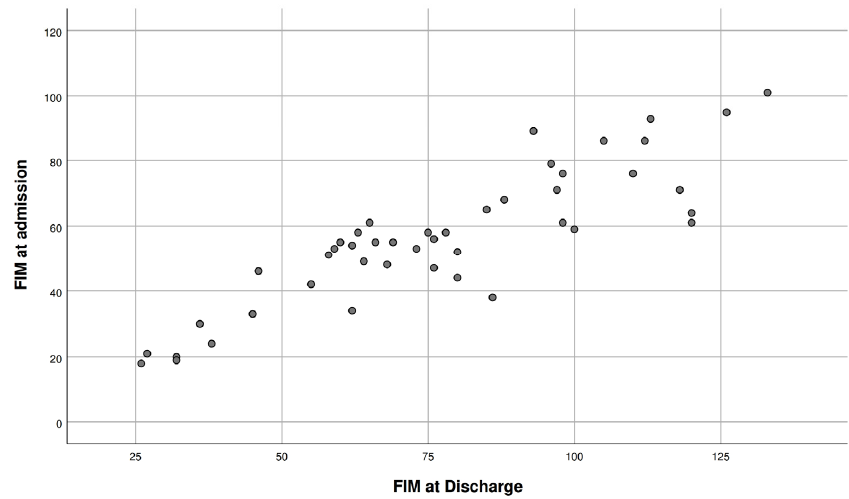
Figure 1. Positive correlation between FIM at admission and FIM at discharge.